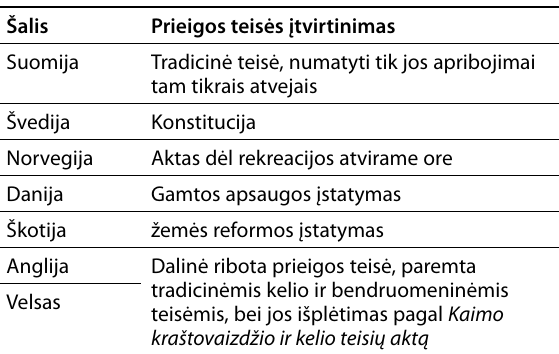
Tab le 1. Ju ri di cal me ans of im ple men ting the right of ac- cess in Scan di na via and the Uni ted king Šalis